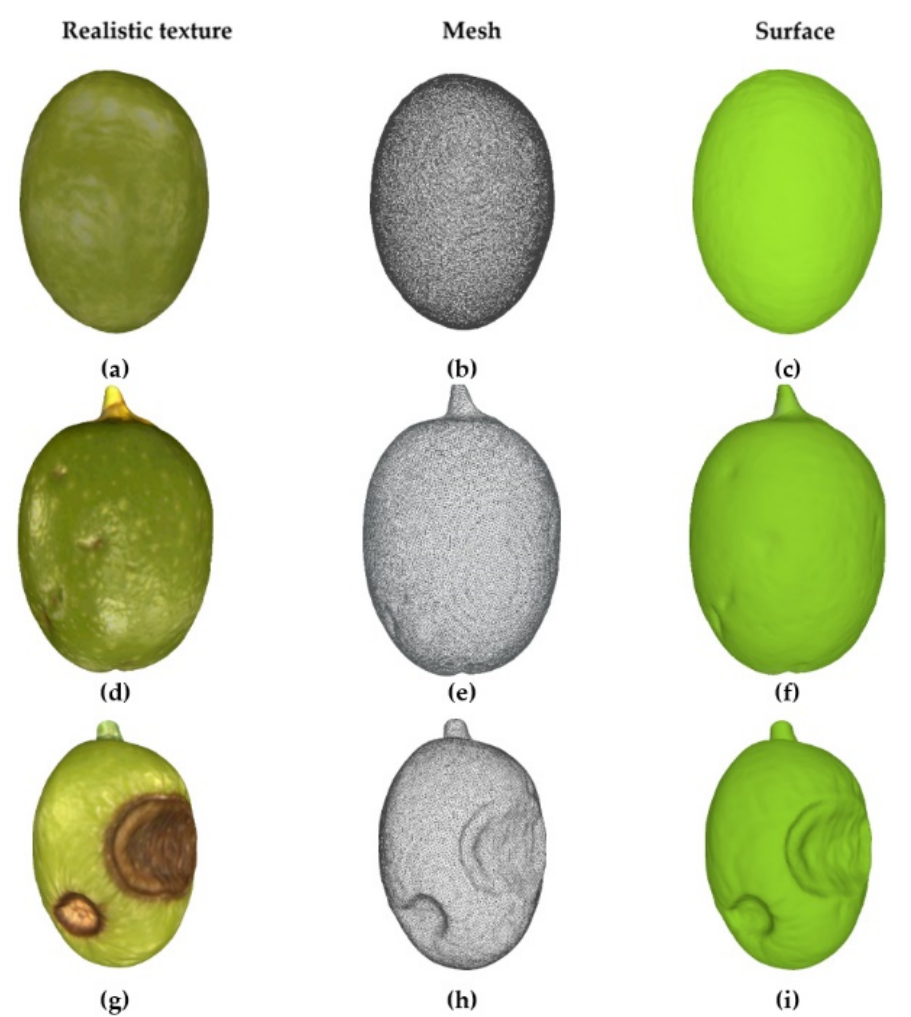
Figure 19. Examples of Hojiblanca variety olives: ( a , d , g ) 3D mesh texturing; ( b , e , h ) mesh, and ( c , f , i ) surface.